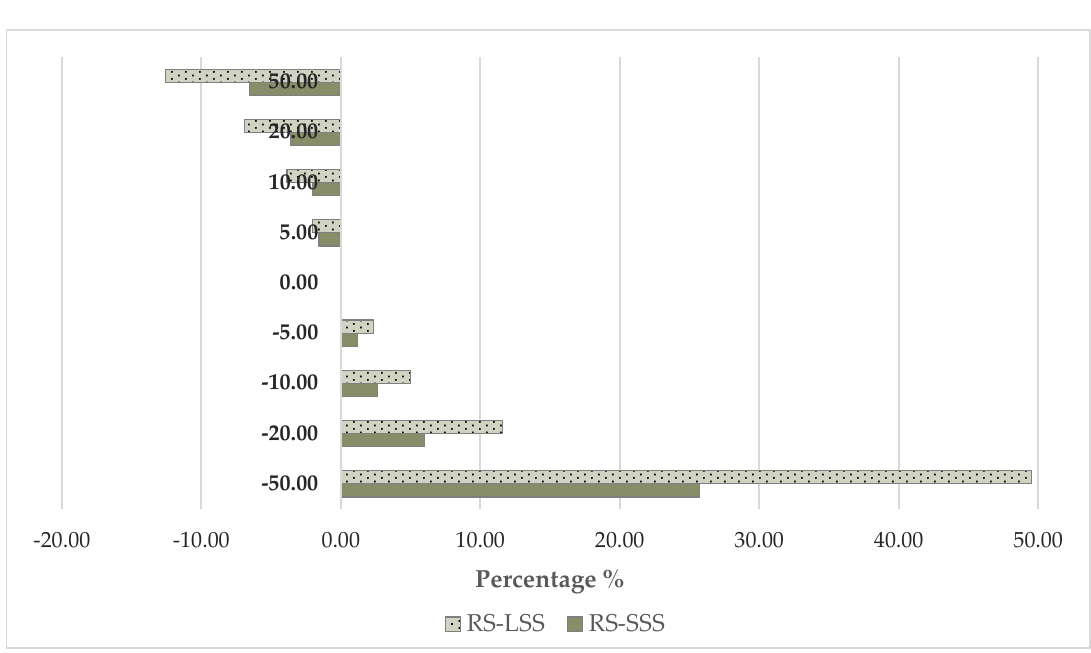
Figure 11. Sensitivity analysis—total cost vs. annual use (RS—Robotic System; SSS—Small-Scale Scenario; LSS—Large-Scale Scenario).